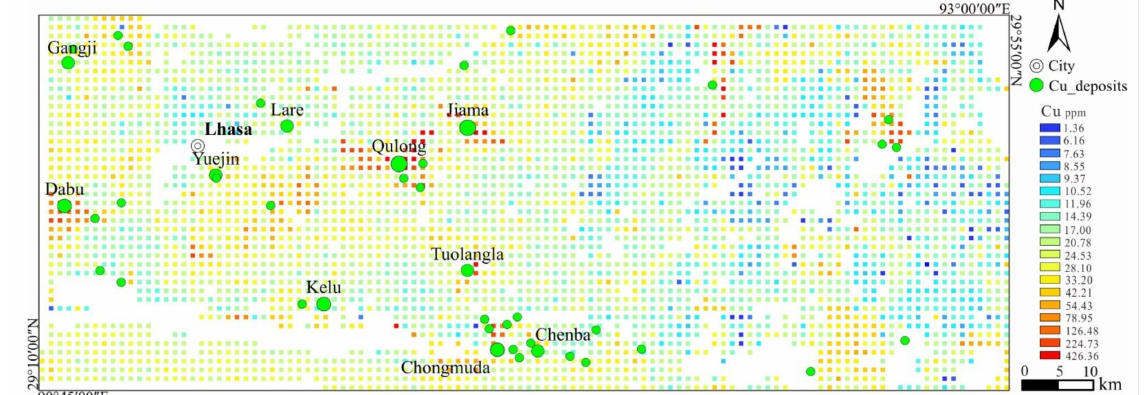
Figure 6. Raster map of Cu: the study area is divided into 216 × 82 grids with a grid size of 1 km × 1 km.